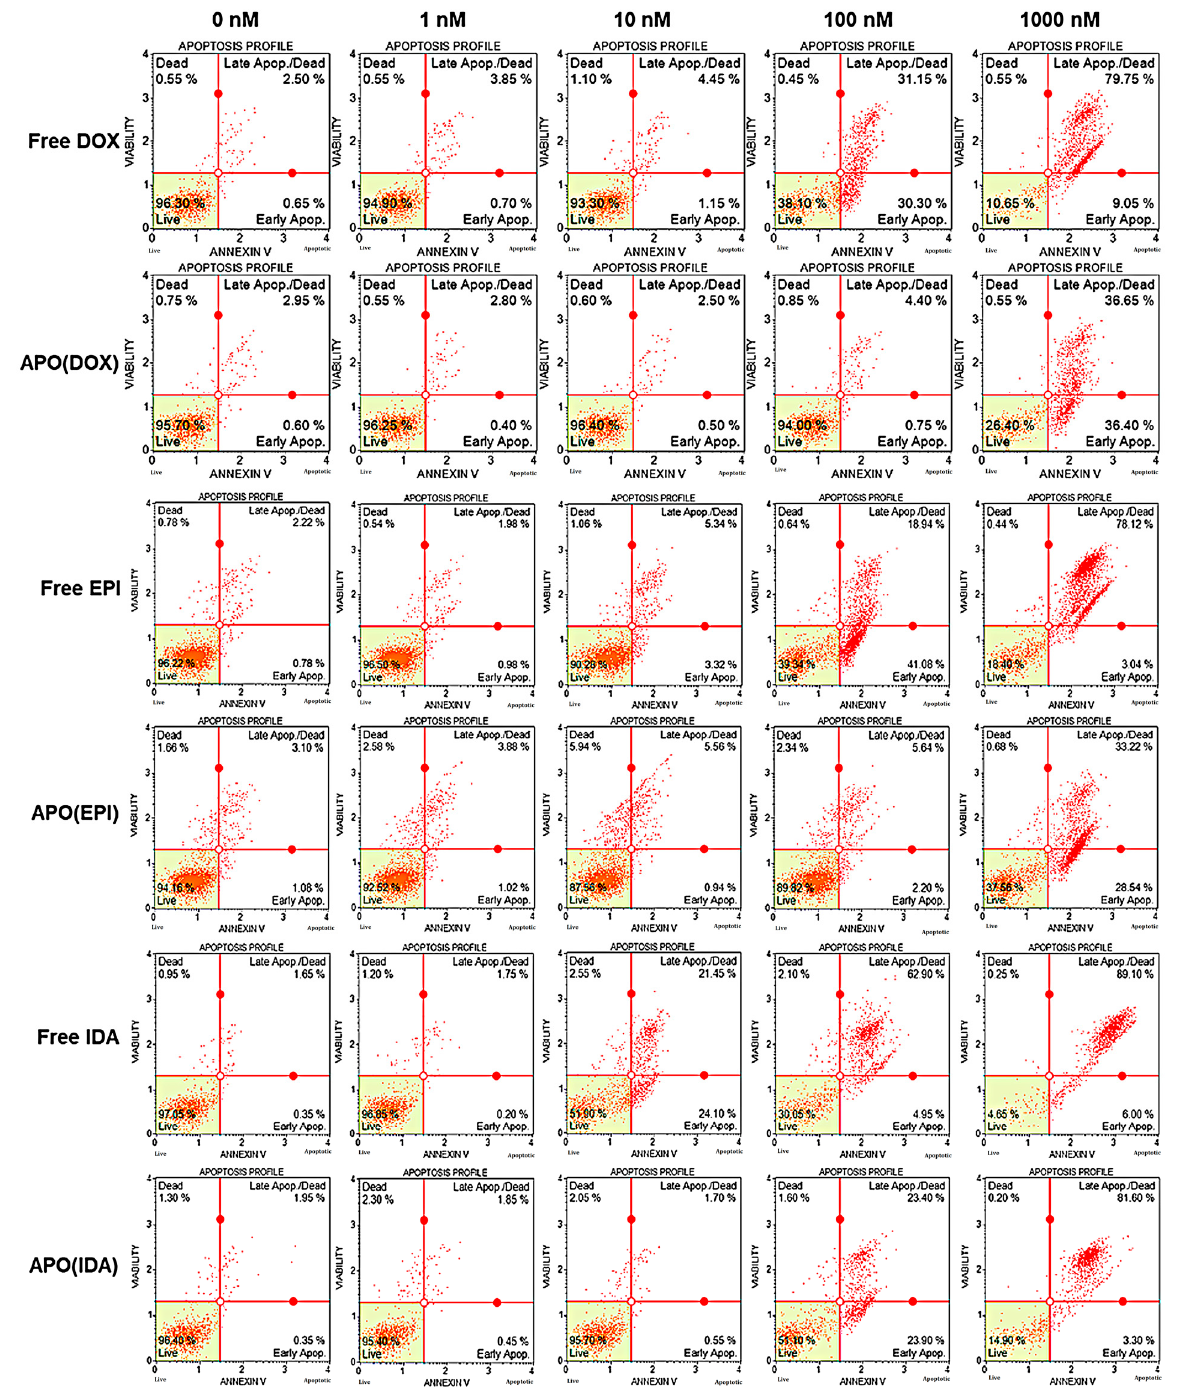
Figure 4. Flow cytometry apoptosis profiles for 7-AA D staining (DNA accessibility index) vs. annexin V staining (membrane damage index) for MDA-MB-231 breast cancer cells treated for 72 h with indicated concentration of anthracycline: (column 1) 0 nM, (column 2) 1 nM, (column 3) 10 nM, (column 4) 100 nM, and (column 5) 1000 nM, using different free anthracyclines (row 1—DOX, row 3—EPI, and row 5—IDA) and APO(drug) nanocarriers with encapsulated anthracyclines (row 2— APO(DOX), row 4—APO(EPI), and row